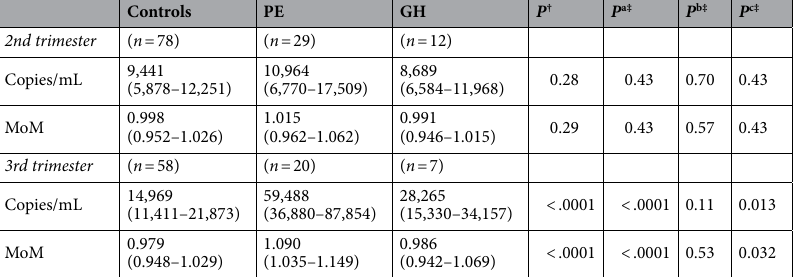
Table 2. Comparison of methylated HYP2 levels and MoM values between specific groups of patients and controls in the second and third trimesters. Data are given as median (interquartile range). P a , PE versus controls; P b , GH versus controls; P c , PE versus GH. GH gestational hypertension, MoM multiple of the median, PE preeclampsia. † P value by the Kruskal–Wallis test. ‡ P value by the Wilcoxon rank sum test (adjusted by the step-up Bonferroni method).